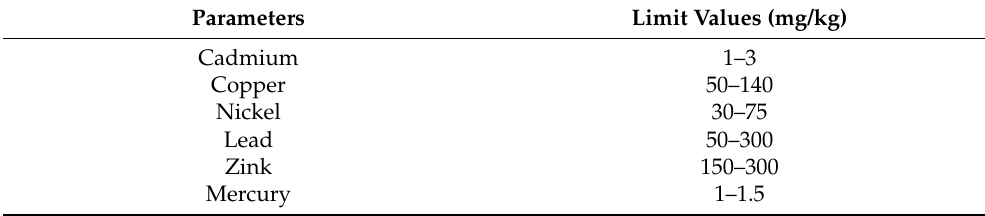
Table 2. Limit values of heavy metals